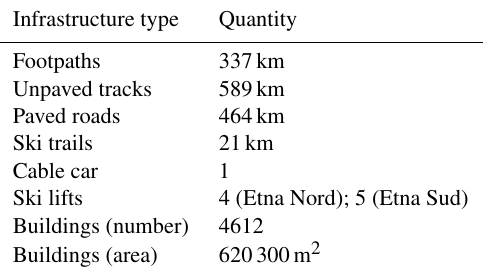
Table 1. Infrastructure within 10km of the summit craters of Mount Etna (OpenStreetMap Foundation, 2017a, from 2017b). The build- ings include an observatory and huts, as well as industrial, commer- cial and residential